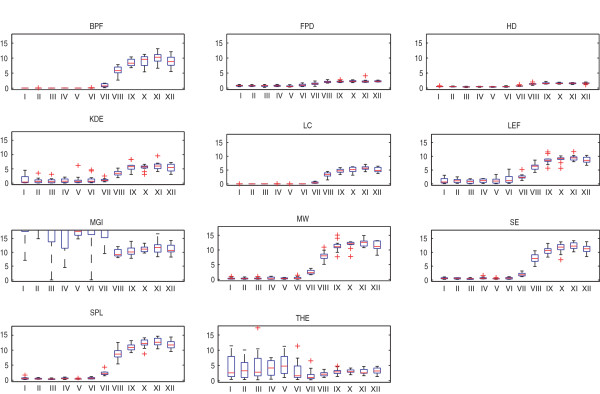
Results for the well plate experiment. The boxplots show number of spots detected per cell in each image, grouped according to the dose level. Parameters of each detection method have been tuned for the data, but here the lack of ground truth reference renders parameter optimization through comparison against reference impossible.